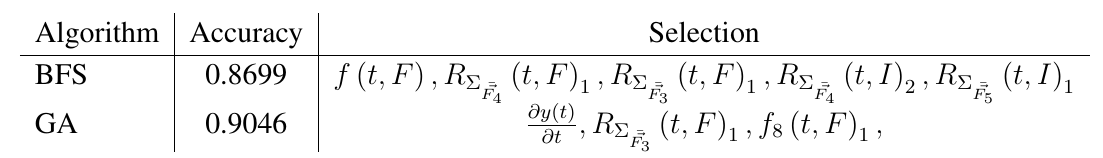
Table 4. Features found by by Best First Search (BFS) and Genetic Algorithm(GA) for classificating three activities